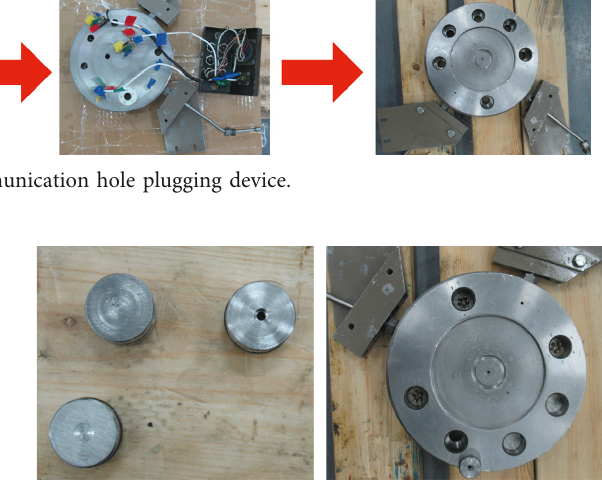
Figure 8: AE communication hole